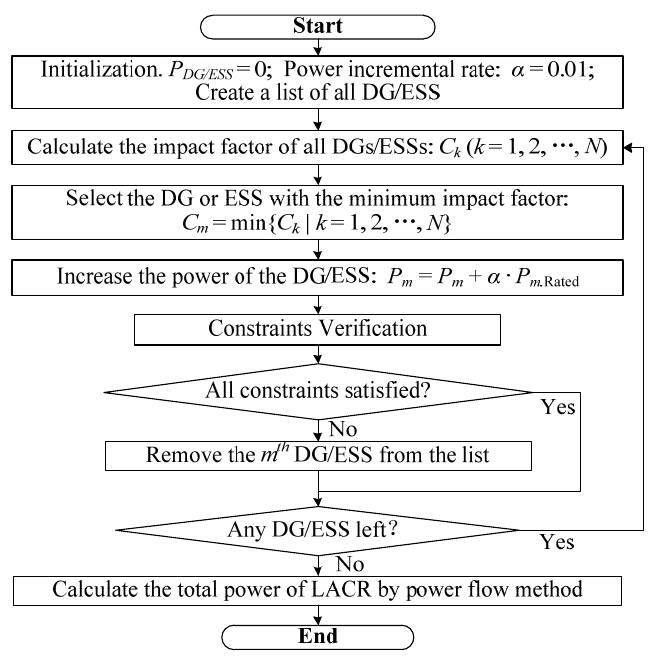
Figure 4. Block diagram of calculating the power supply capacity of the LACR.